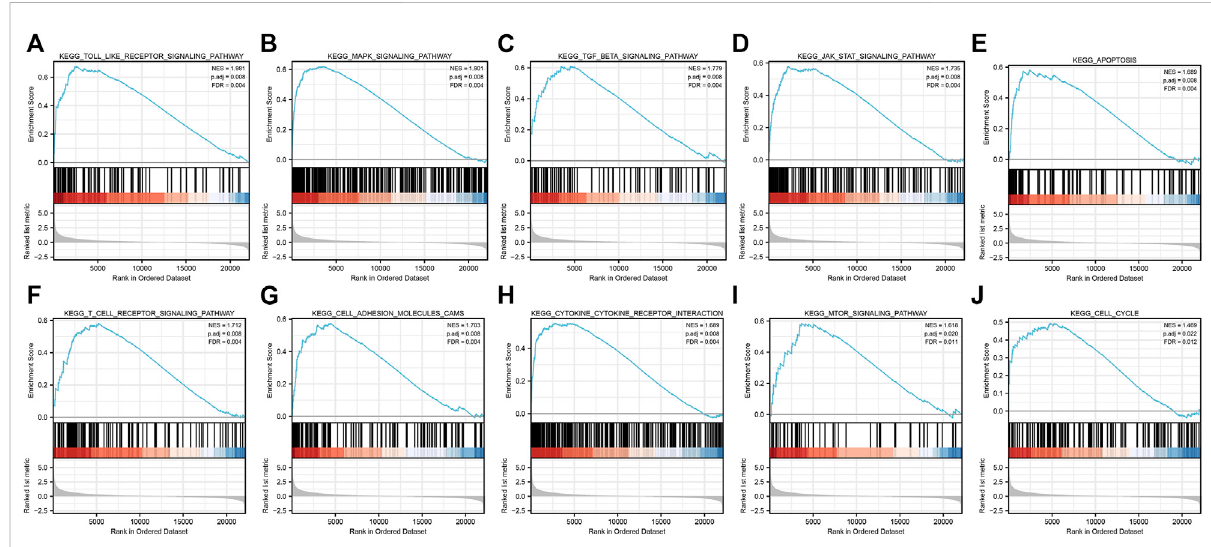
FIGURE 5 GSEAofcommondifferentialgenes. (A) Toll-likereceptorsignalingpathway, (B) MAPKsignaling pathway, (C) TGF- β signalingpathway, (D) JAK- STAT signaling pathway, (E) apoptosis signaling pathway, (F) T-cell receptor signaling pathway, (G) cell adhesion molecules (CAMs) signaling pathway, (H) cytokine – cytokine receptor interaction signaling pathway, (I) mTOR signaling pathway, and (J) cell cycle signaling pathway. Note: all these pathways were mainly enriched in AKI caused by ischemia –